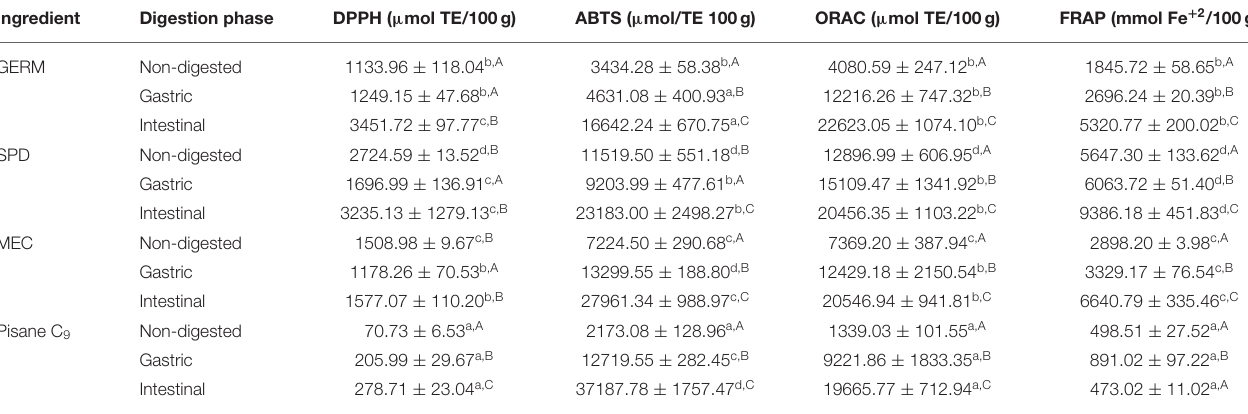
TABLE 6 | Effect of in vitro digestion on antioxidant activity of wheat ingredients. Ingredient